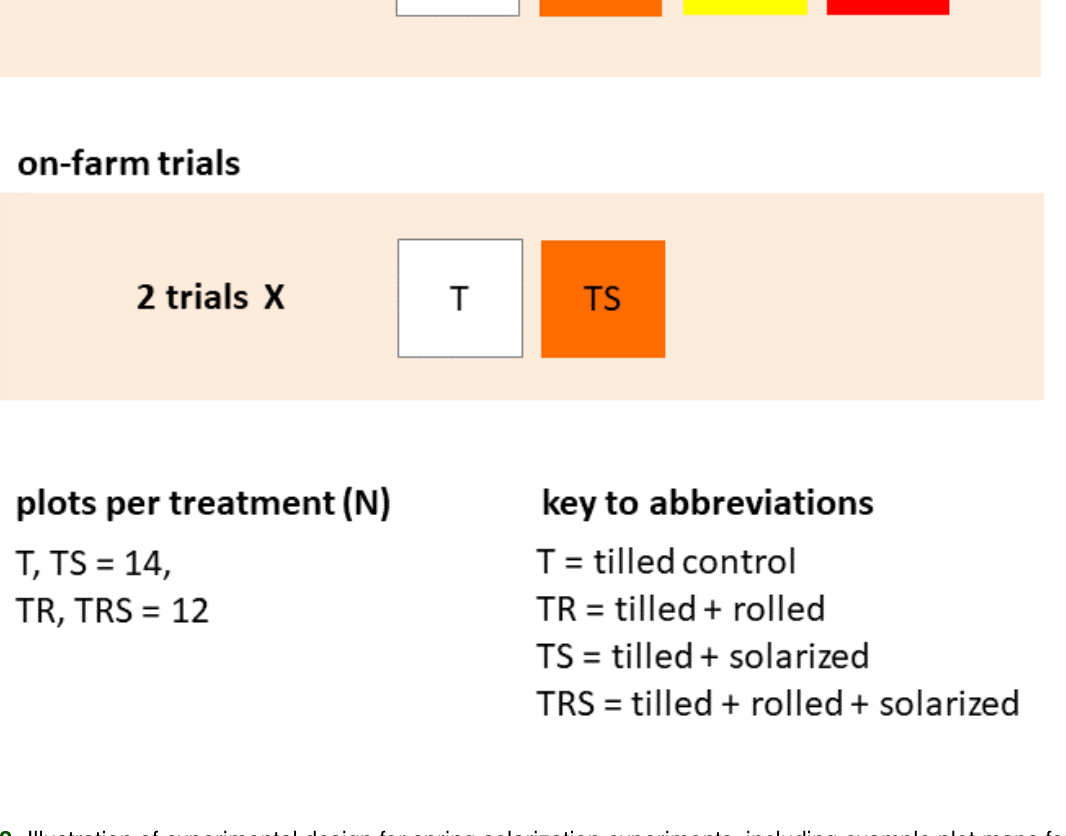
Figure A2. Illustration of experimental design for spring solarization experiments, including example plot maps for one of four experimental site-years and one of two on-farm